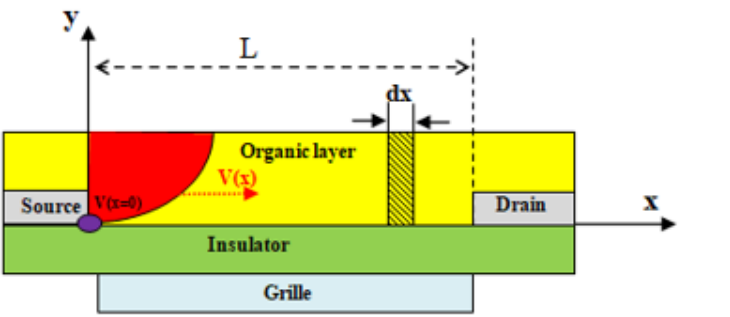
Figure 2. Geometry definition of a simplified structure of OTFTs used in the calculation of the drain current expression (Equation (1)) in the frame of the graduated channel approximation ( 𝐸 (cid:3052) ≫ 𝐸 (cid:3051) ).